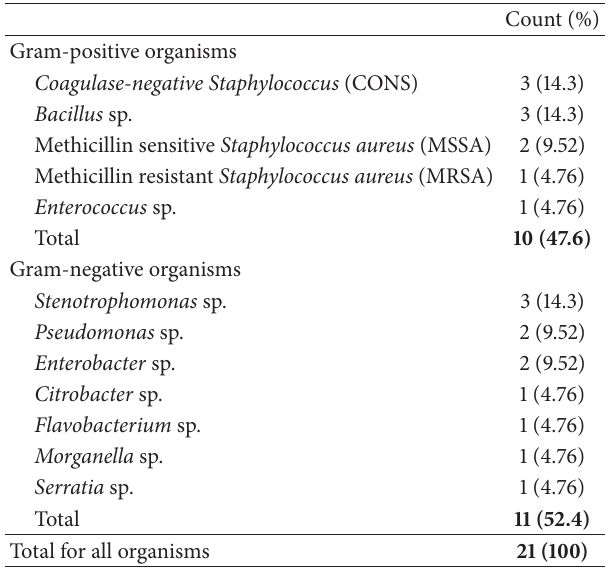
Table 2: Bacterial isolates from 18 blood cultures.